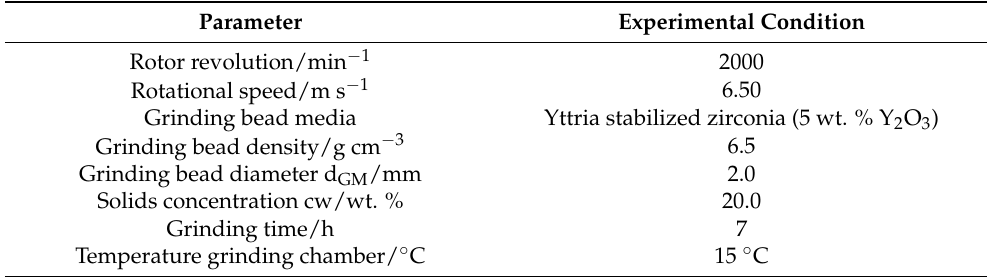
Temperature grinding chamber/ ◦ C 15 ◦ C